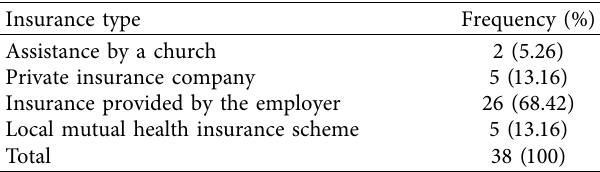
Table 2: Health insurance